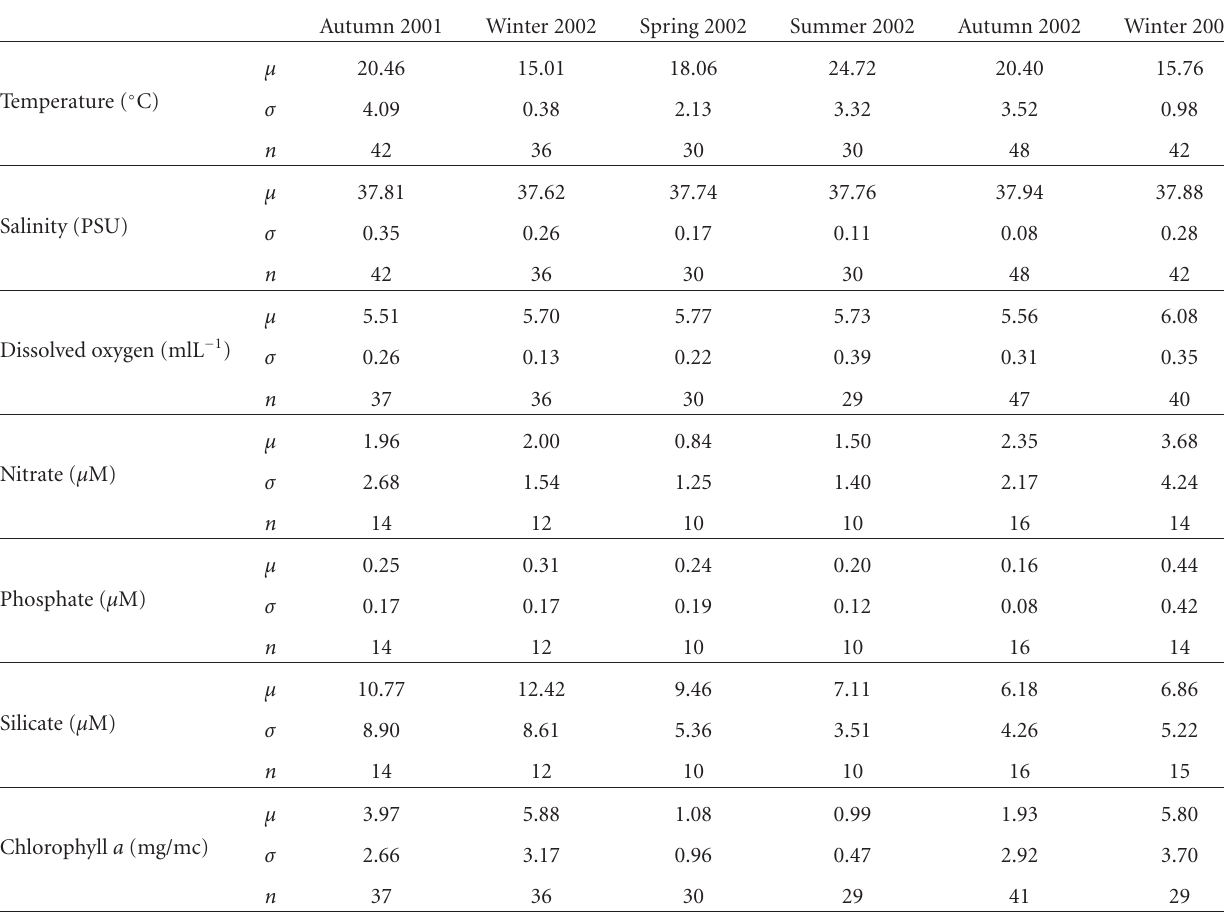
Table 1: Mean values ( μ ), standard deviation ( σ ), and number of samples ( n ) for all examinated